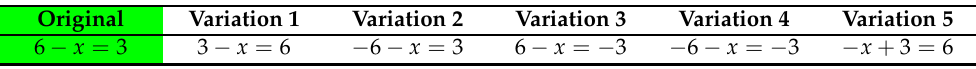
Table 4. Examples of type 3 equations and